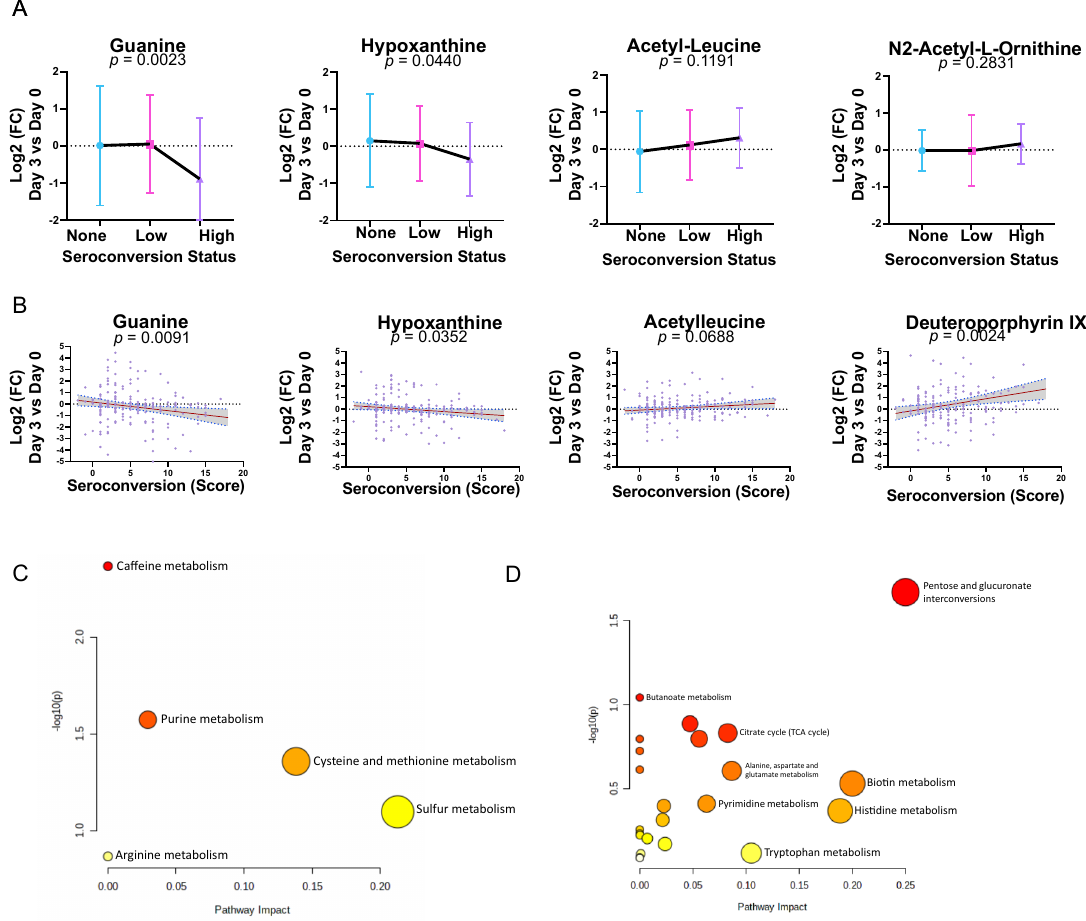
Figure 3. Metabolites associated with the response of the High-responders to vaccination. ( A ) Subject- specific changes in metabolites with respect to the seroconversion status on Day 3 vs. Day 0. Error bars represent the standard deviation. ( B ) Overall correlations of metabolite markers with the subject seroconversion score, n = 179, where the p -value represents the significance of the non-zero slope for linear regression. The red line represents the best-fit regression, and the grey area represents the 95% confidence interval for the line of regression. ( C , D ) Metabolic pathway analysis of the High-responders and None-responders, respectively. The x-axis represents the pathway impact (% of pathway covered), and the y-axis represents the statistical